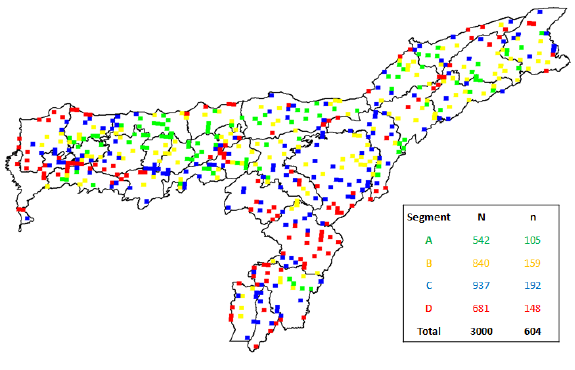
Figure 5. An example of sample segments selected for rice classification in Assam state